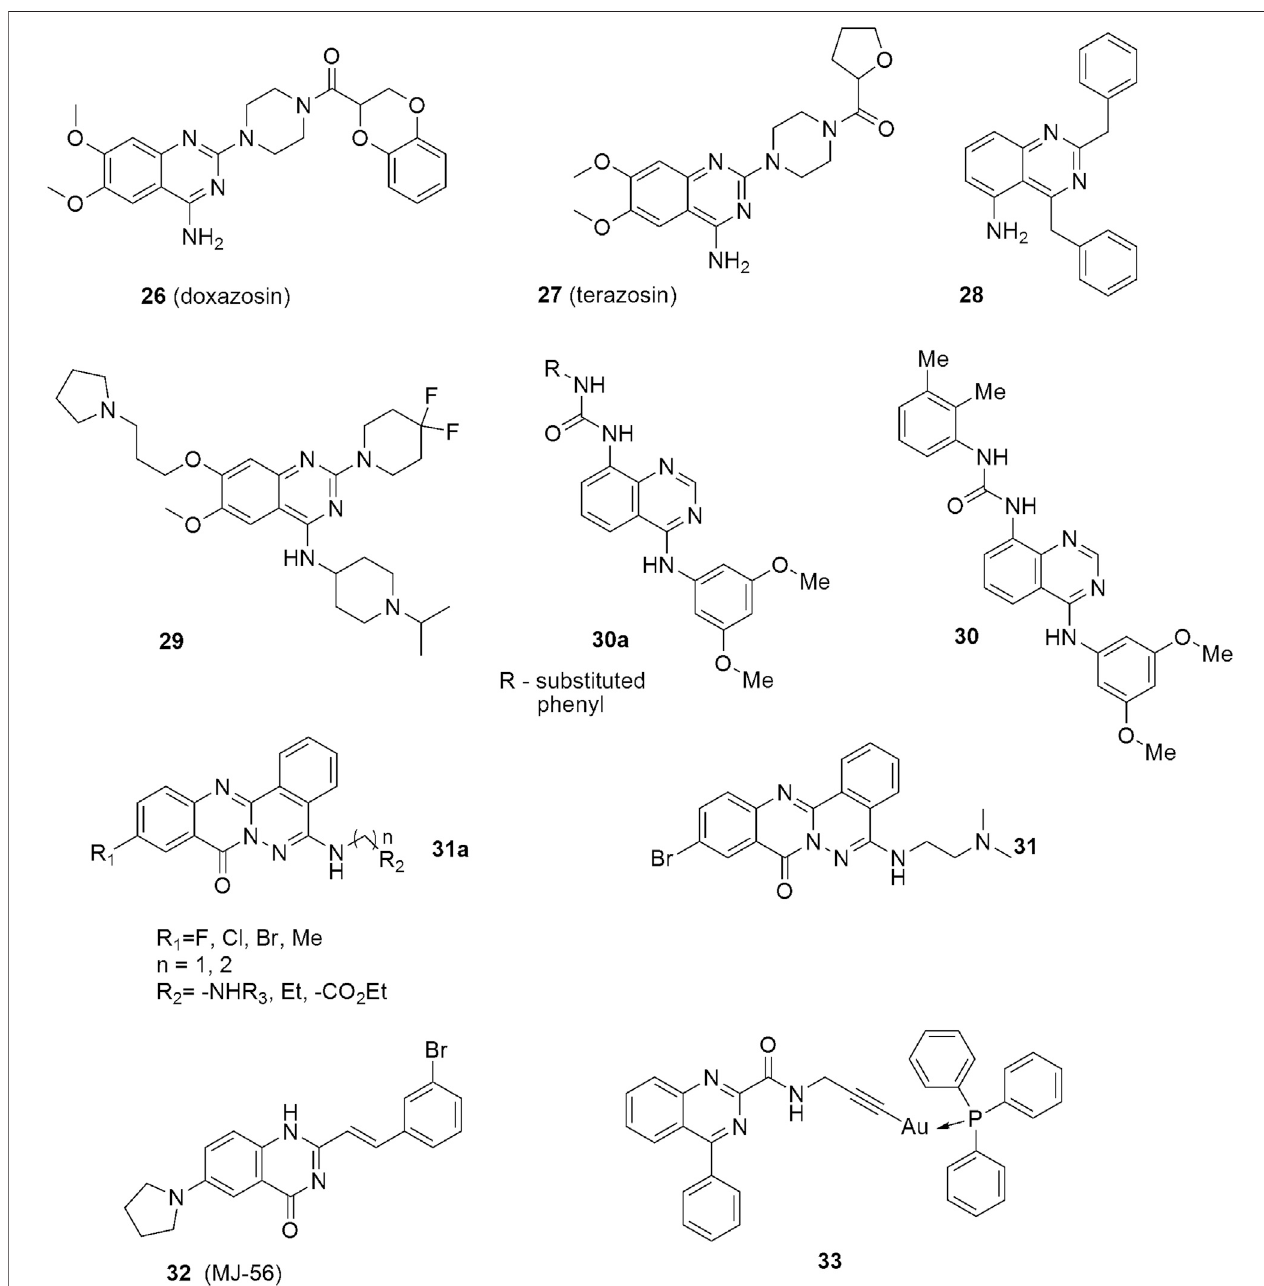
FIGURE 4 | Structures of quinazoline derivatives exhibiting anticancer effects against urinary bladder cancers.